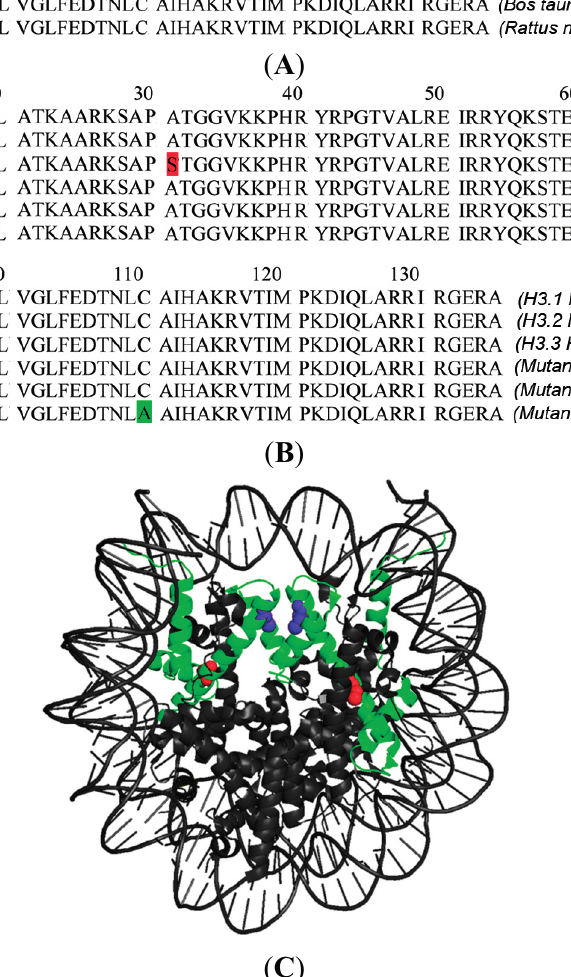
Figure 1. ( A ) H3.1 sequence conservation between Homo sapiens , Mus musculus , Bos taurus and Rattus norvegicus ; ( B ) Sequences of the H3 variants H3.1, H3.2, H3.3 and the mutants constructed and analysed here. The mutant H3.1 C96S equals H3.2 (red: sequence deviations of H3.1 and H3.3 from H3.2; green: H3.1 mutants studied here); and ( C ) Nucleosome structure [105,106]. Both H3 copies are displayed in green with C96 in red and C110 in blue. C96 and C110 are located in different α